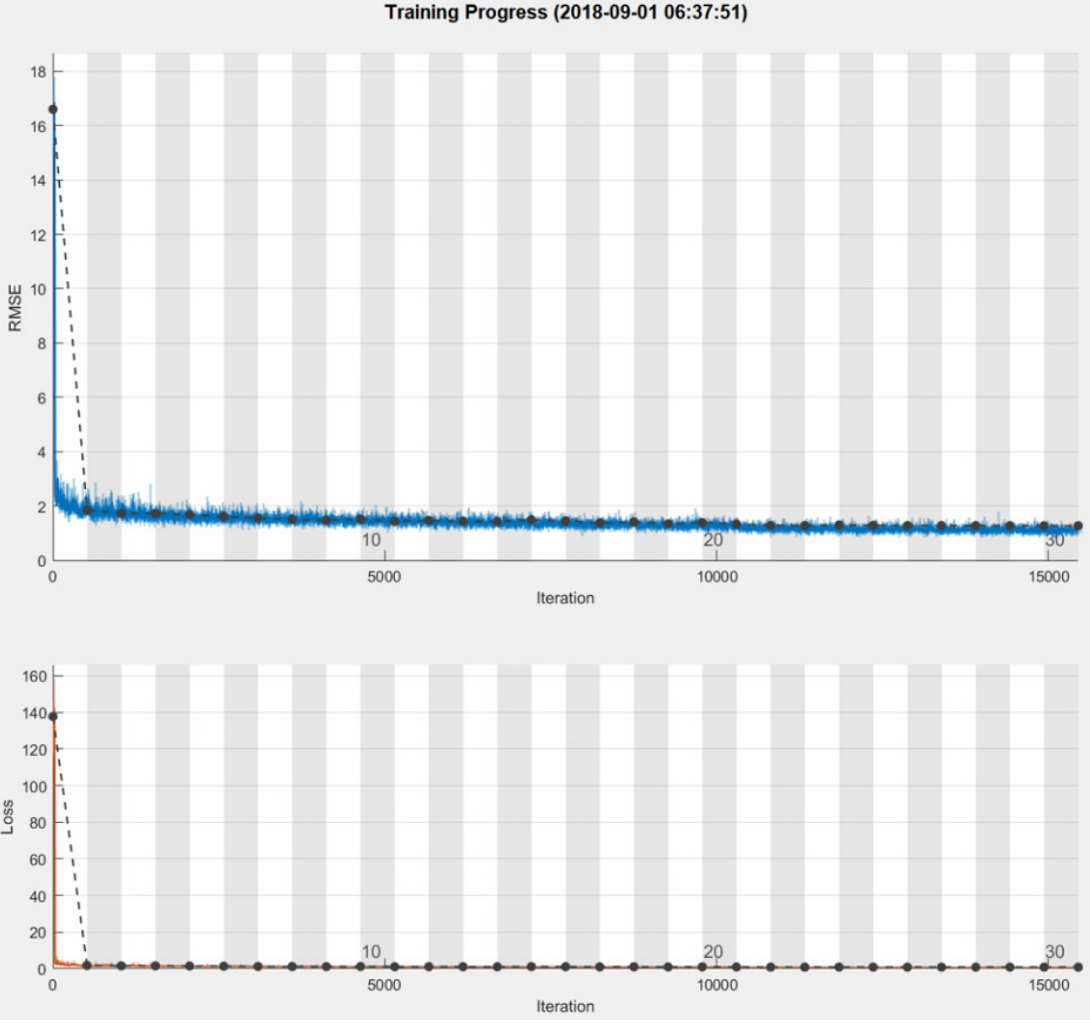
Figure 12. Training process: ( top ) root mean square error curve; ( bottom ) loss